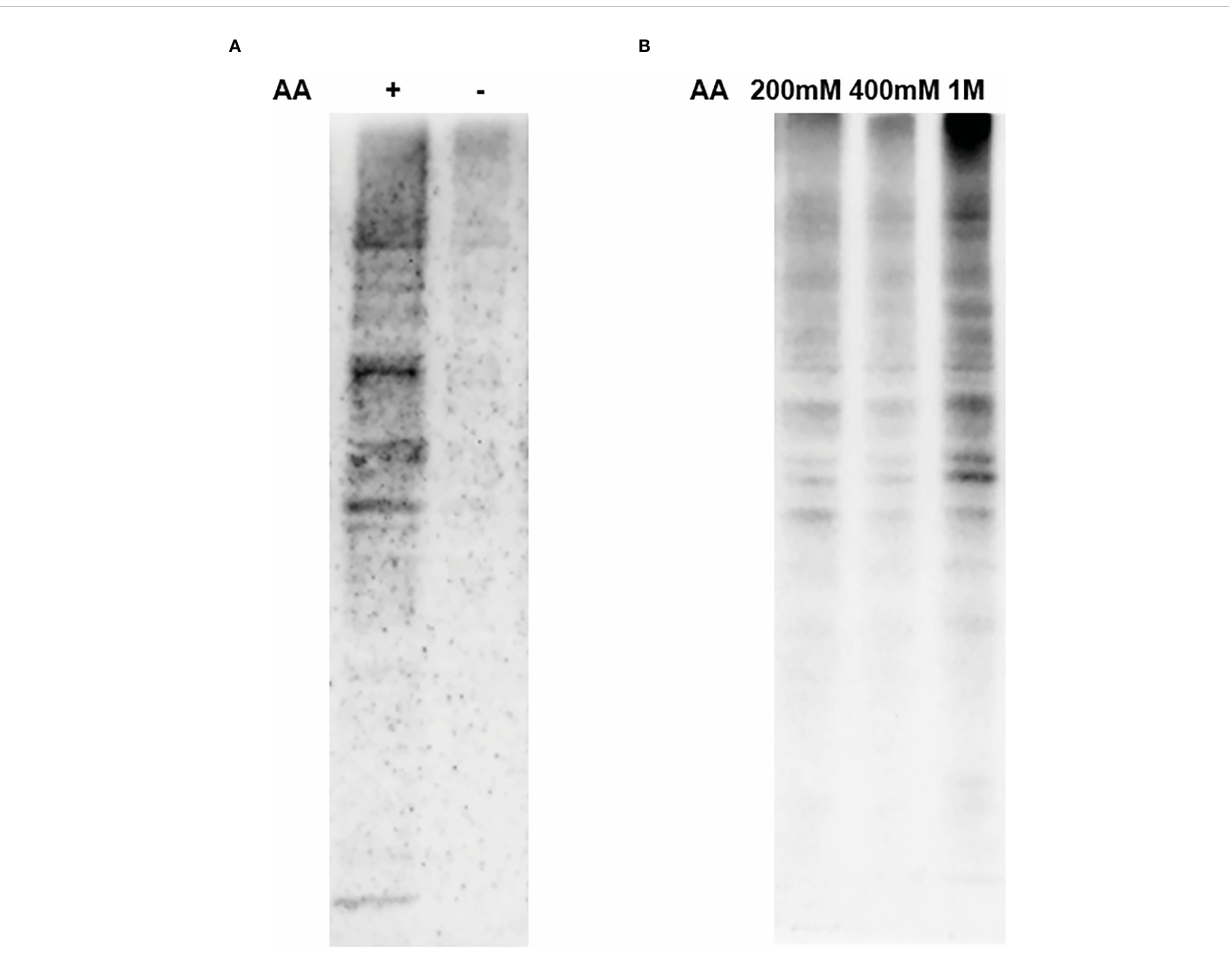
FIGURE 2 Results of AA reducing SNO proteins. (A) The effect of AA on reducing SNO proteins. (B) The reduction effect of different AA concentrations (200 mM, 400 mM, 1 M) on SNO